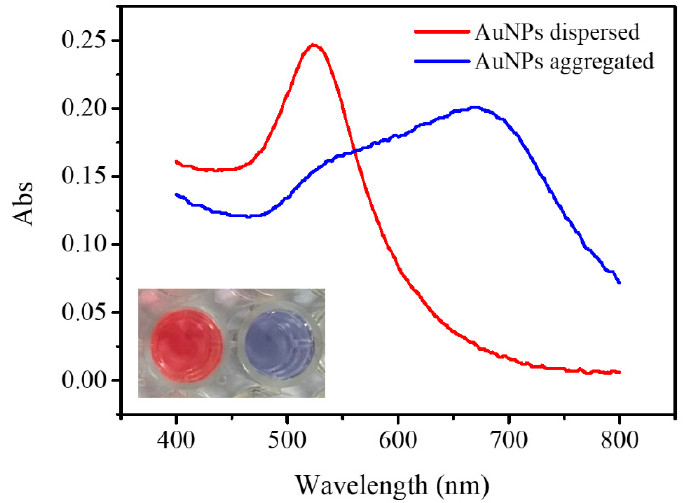
Figure 2. Comparison of the dispersed and aggregated AuNPs describing UV-absorbance spectra. Salt contained 1 M of NaNO 3 (inset: colorimetric change).